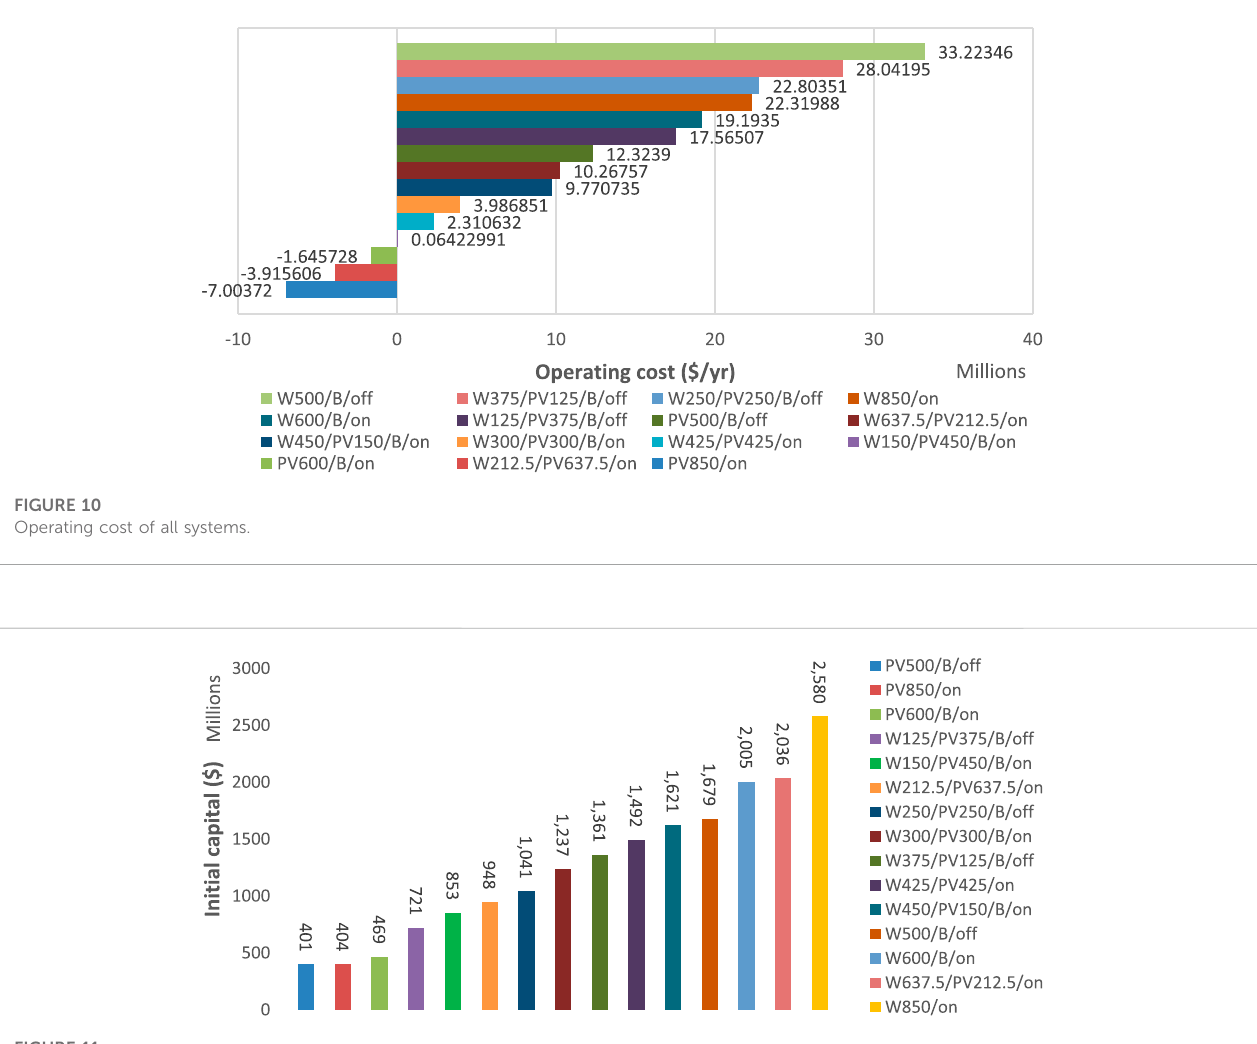
FIGURE 11 Initial capital of all